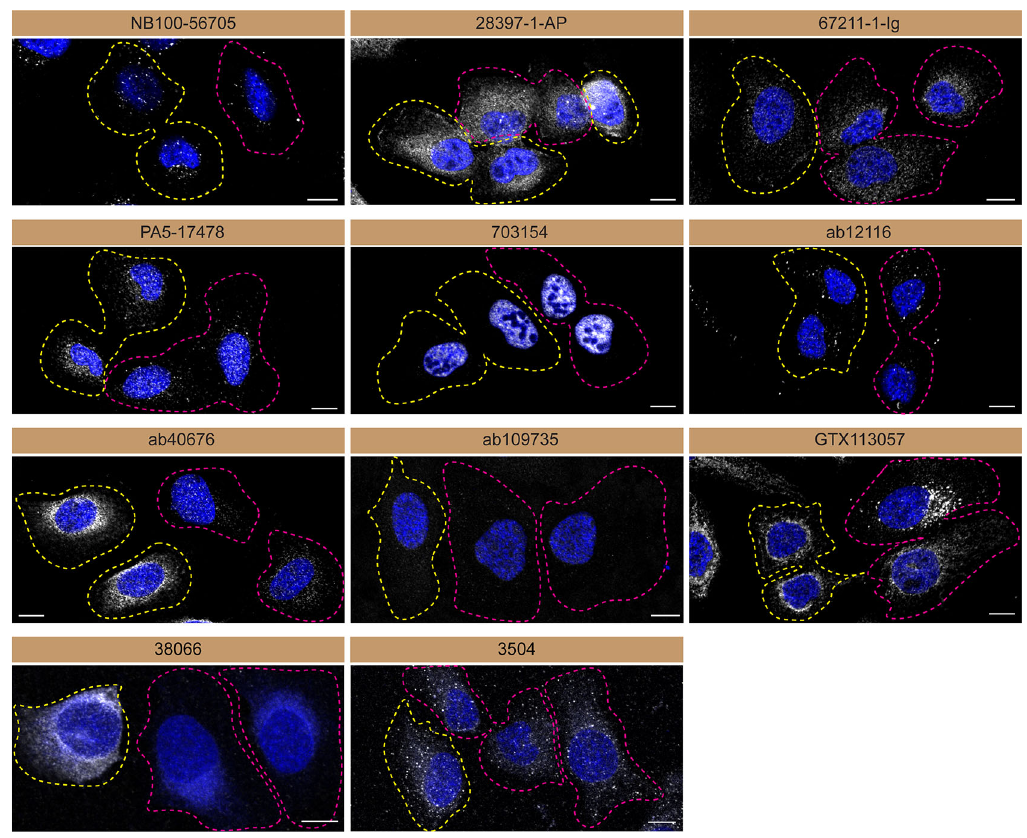
Figure 3. Serine/threonine-protein kinase TBK1 antibody screening by immunofluorescence. U2OS WT and TBK1 KO cells were labelled with a green or a far-red fluorescent dye, respectively. WT and KO cells were mixed and plated to a 1:1 ratio on coverslips. Cells were stained with the indicated TBK1 antibodies and with the corresponding Alexa-fluor 555 coupled secondary antibody including DAPI. Acquisition of the blue (nucleus-DAPI), green (WT), red (antibody staining) and far-red (KO) channels was performed. Representative images of the merged blue and red (grayscale) channels are shown. WT and KO cells are outlined with yellow and magenta dashed line, respectively. Antibodies were tested at 1.0 μ g/ml. When the concentration was not indicated by the supplier, we tested the antibodies at 1/500 or 1/1000. At this concentration, the signal from each antibody was in the range of detection of the microscope used. Antibody dilution used: NB100-56705 at 1/1000; 28397-1-AP at 1/500; 67211-1-Ig at 1/1000; PA5-17478 at 1/1000; 703154 at 1/500; ab12116 at 1/1000; ab40676 at 1/1500; ab109735 at 1/500; GTX113057